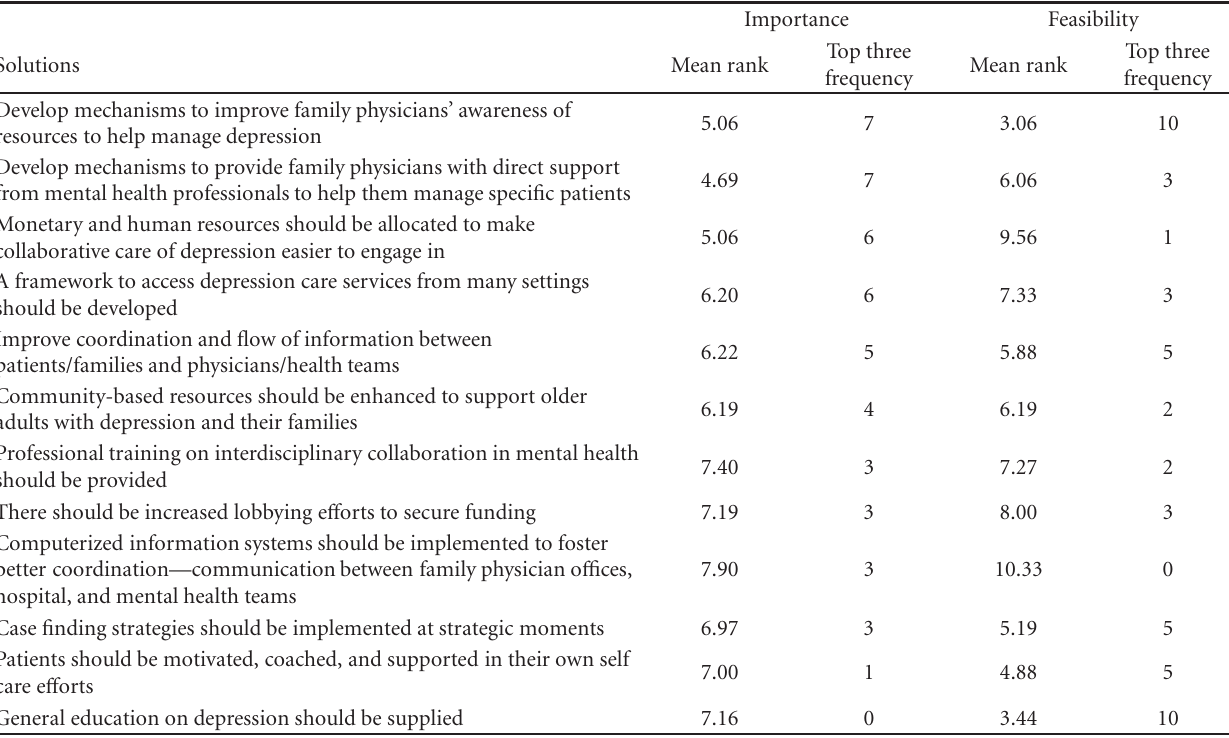
Table 1: Mean and frequency rankings of important and feasible solutions to depression management ranked by conference attendees ( N = 16).